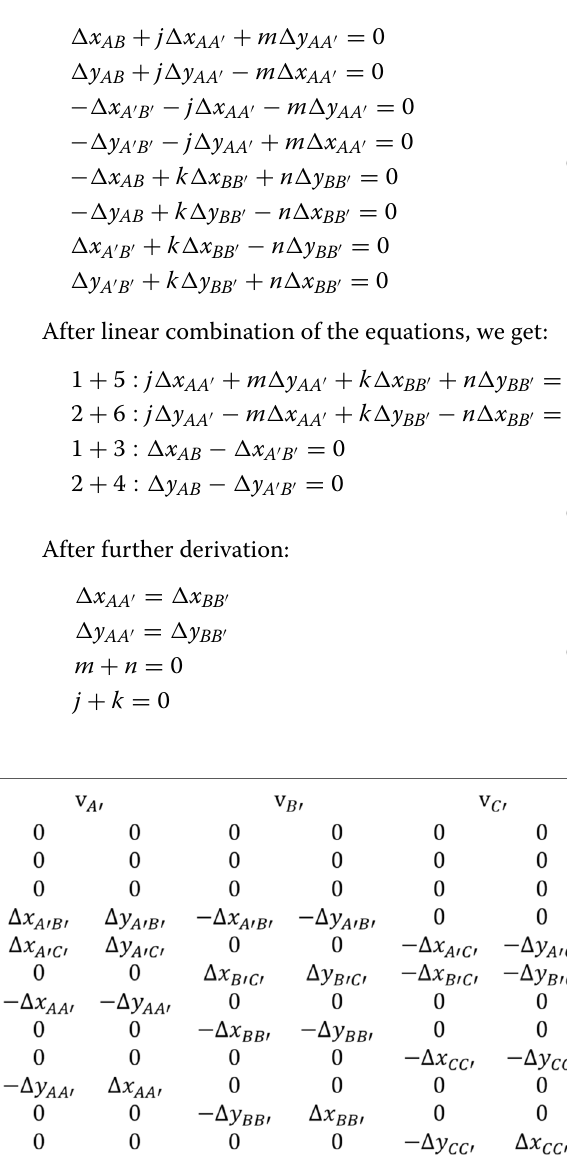
Fig. 4 Rigidity matrix R ( G , p